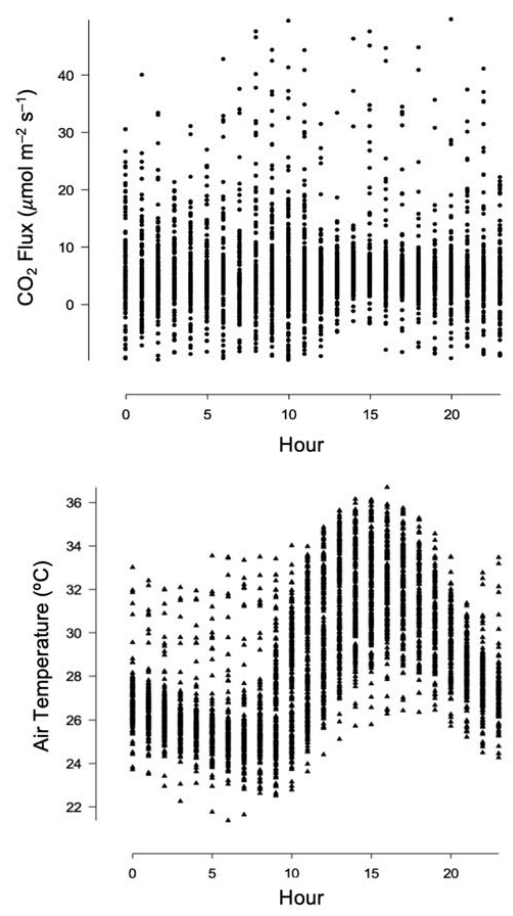
Figure 5. The hourly, daily trend of the CO 2 flux and air temperature at the site.